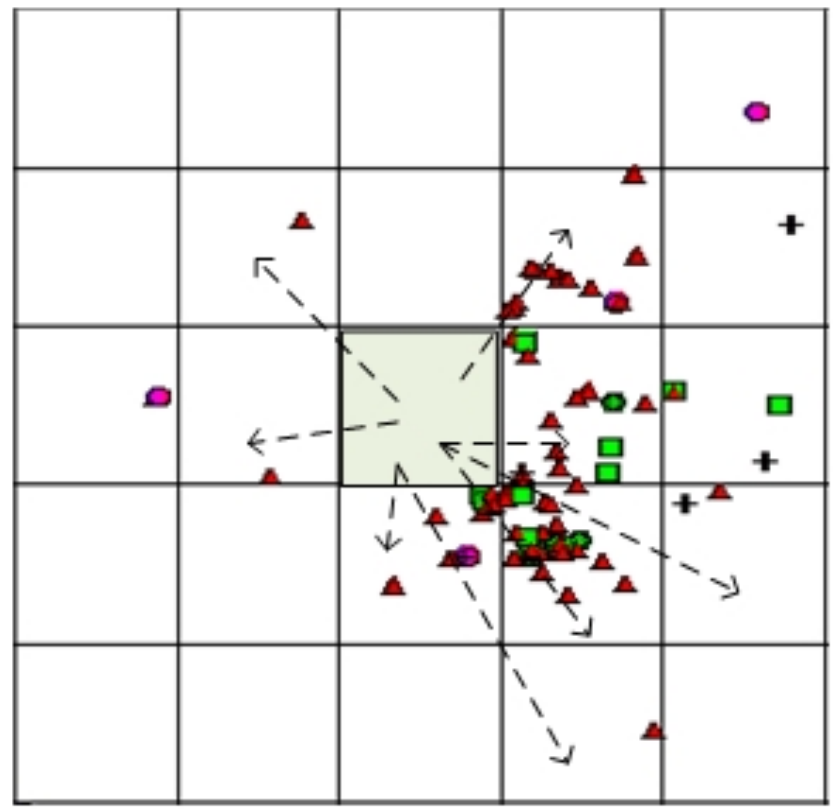
Figure 4. Schematic diagram of the method of influence of terrorist attacks.